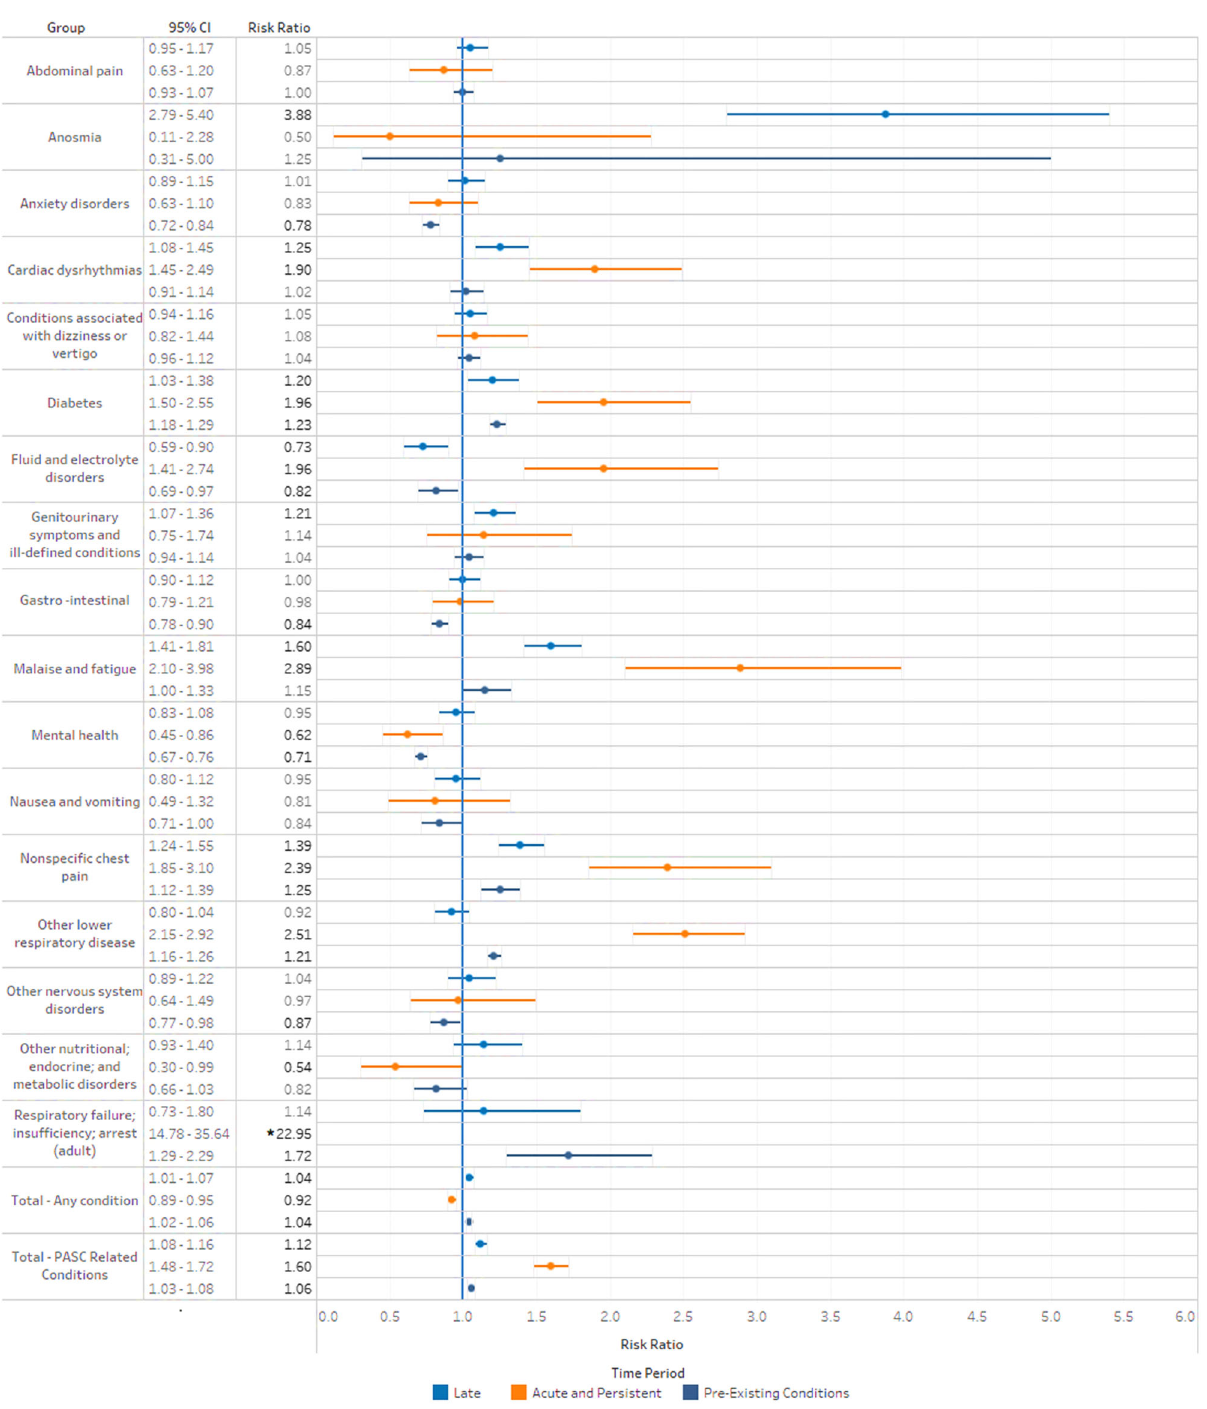
( n =28,118)versusCCSconditionsincidentinthePCR-negativecohort( n =70,293), with 95% con fi denceintervals represented by the respective bands. Utilizing 1.0 as thebaseline,signi fi cantriskratios( p <0.05)forthePASC-relatedconditionscanbe identi fi ed in bold and compared in scale to the other conditions. (*) Asterisk des- ignates that the metric was too large to fi t within the scale of the